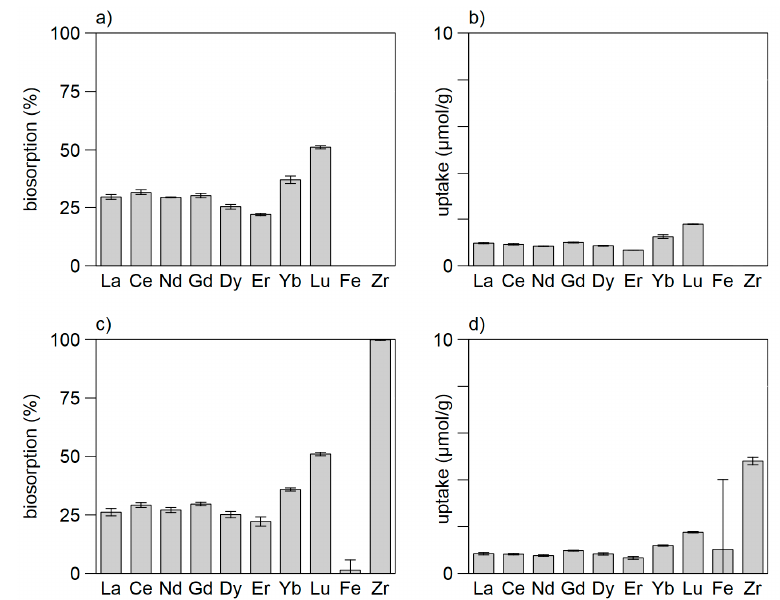
Figure 4. REE biosorption ( a , c ) and uptake ( b , d ) by B. subtilis in absence ( a , b ) and presence ( c , d ) of iron and zirconium (Fe(II): 264 µ mol / L, Zr(IV) 16 µ mol / L, BM 5g / L, pH 2.5). Bars show mean of two parallel assays, error bars show standard deviation.